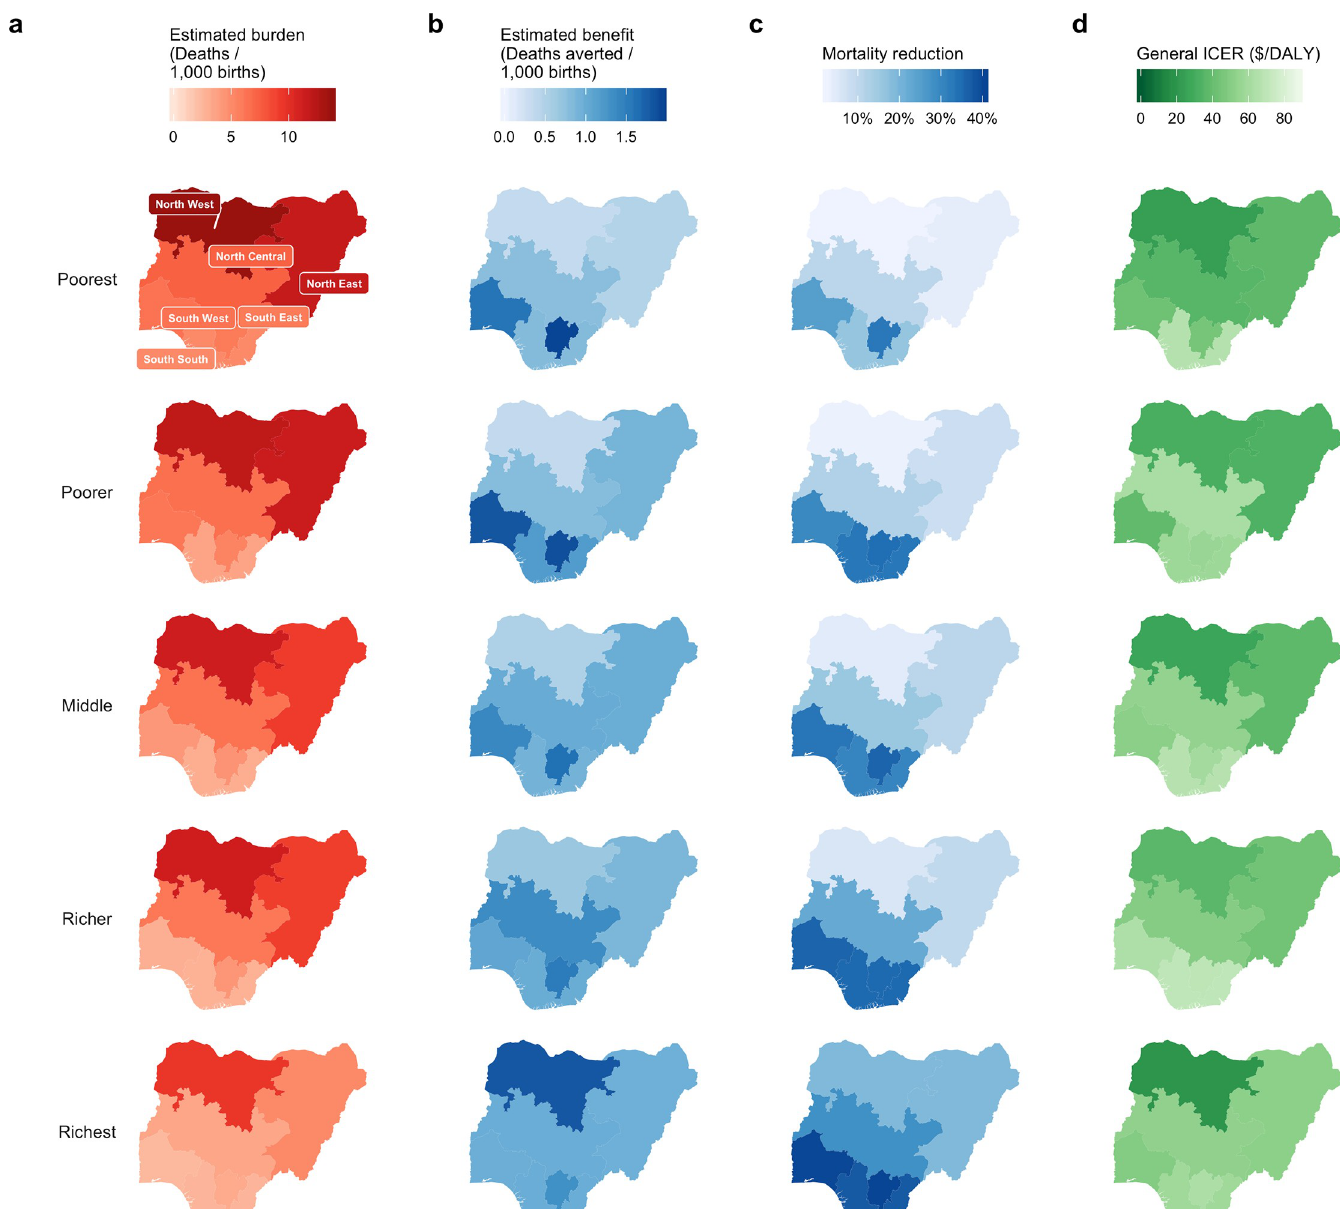
Fig 1. Estimated impact and cost-effectiveness of rotavirus vaccination by region and wealth quintile. Mortality burden (deaths, a) and benefit (deaths averted, b) are expressed as rates per 1000 births over the first five years of life. Benefit is also expressed as mortality reduction (c) which is the percentage of burden prevented by vaccination. Incremental cost-effectiveness ratios (ICERs) are displayed in green (d).